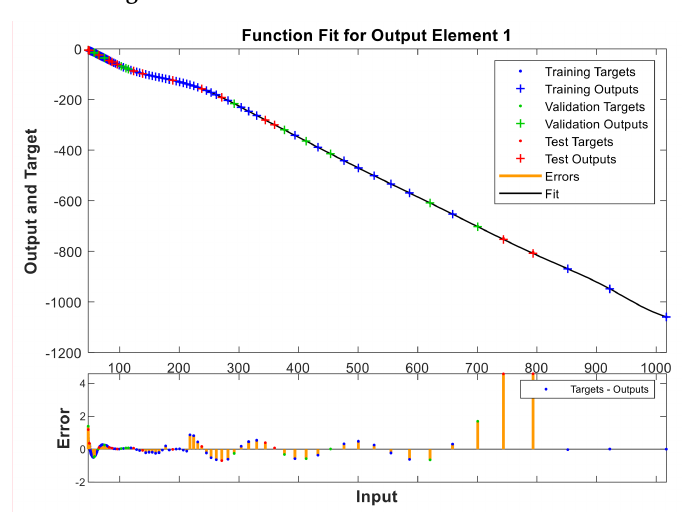
Figure 11. Processed “Gordal Sevillana” at 25 ◦ C.